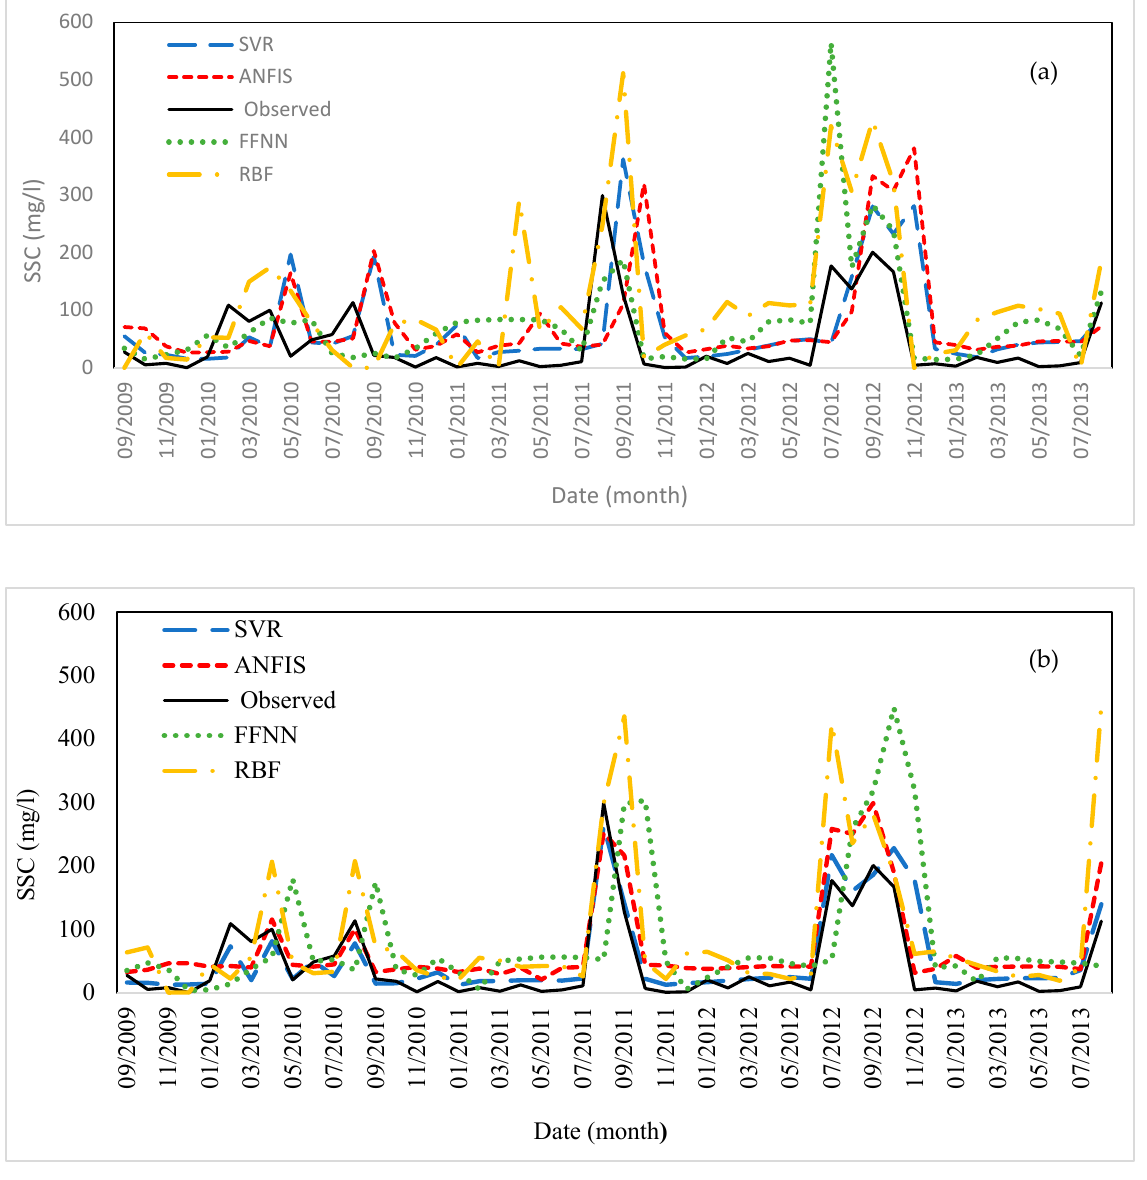
Figure 5. Time series plots of the observed and estimated SSC based on the best input scenarios of group 1 ( a ) and group 2 ( b ) during test phase.